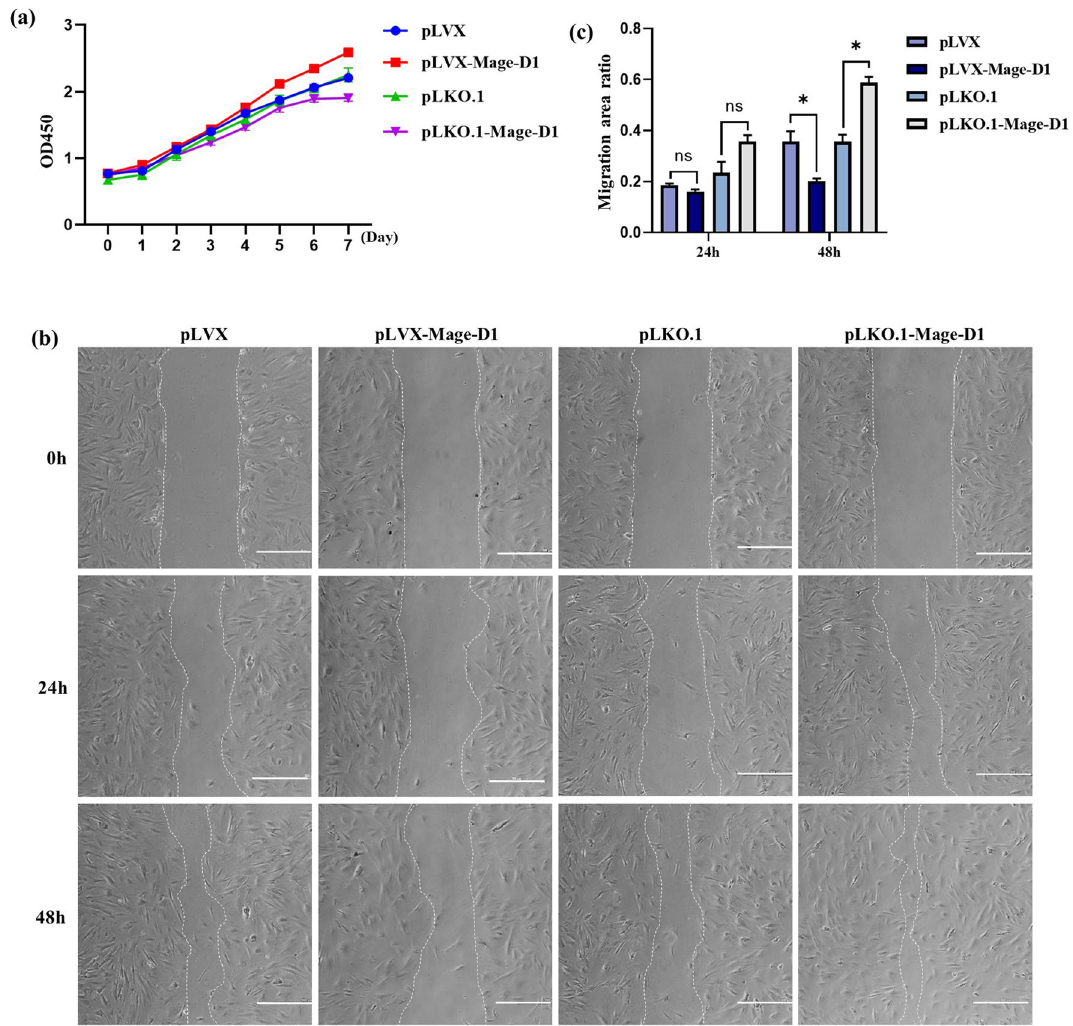
Figure 4. Regulation of Mage-D1 influence the proliferation capacities and migration capacities of E19.5 d EMSCs. ( a ) The proliferation rate was assessed by CCK-8 cultured for 8 days. For raw data see Supplementary Table 4. ( b ) The migration rate was assessed for two consecutive days. Scale bar represents 500 μm. ( c ) The migration rate quantitative statistics of (b). For raw data see Supplementary Fig. S3 and Supplementary Table 5. (ns represents no significance, * P <